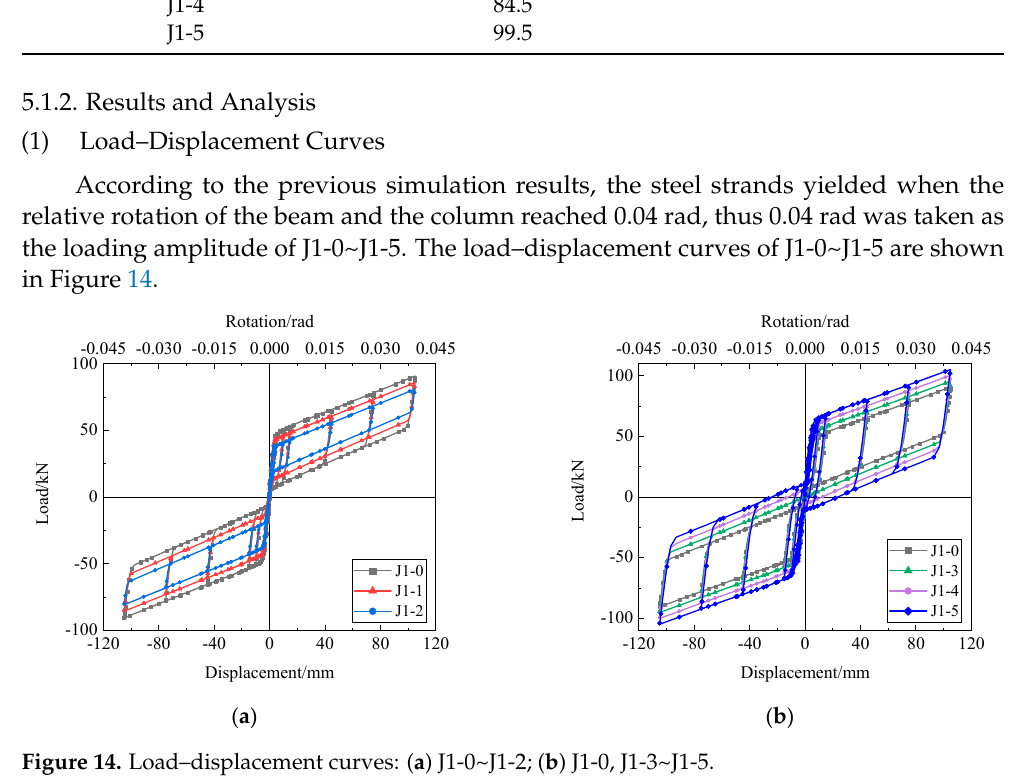
Figure 14. Load–displacement curves: ( a ) J1-0~J1-2; ( b ) J1-0, J1-3~J1-5.